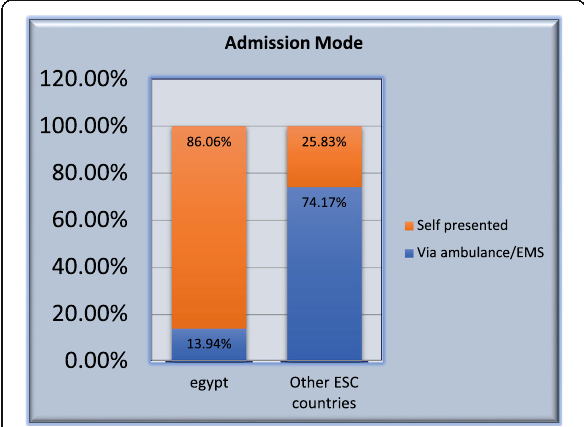
Fig. 1 Admission mode in Egypt vs. other